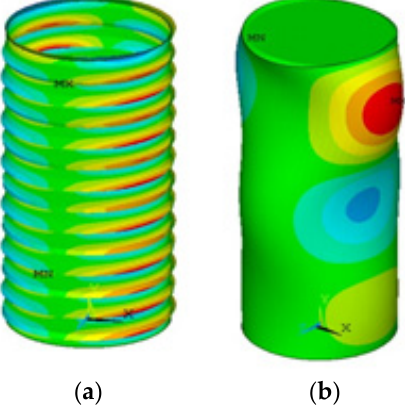
Figure 4. Imperfection shapes. ( a ) Type 1. ( b ) Type 2. Table 1. The used specimen details in the parametric study to evaluate imperfection shape. Cross-Section